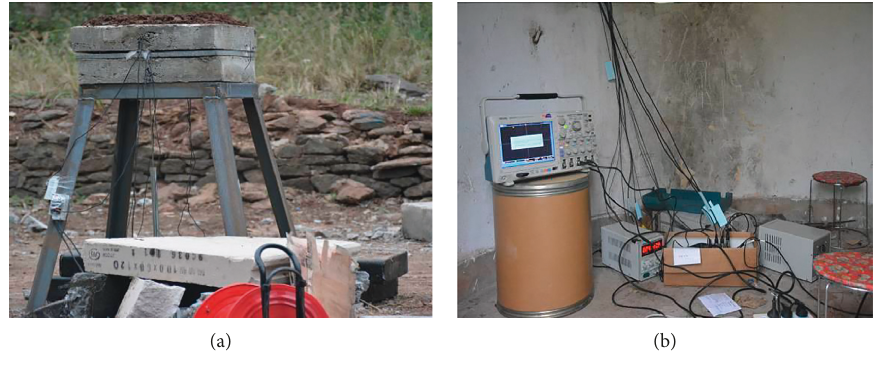
Figure 5: Test site